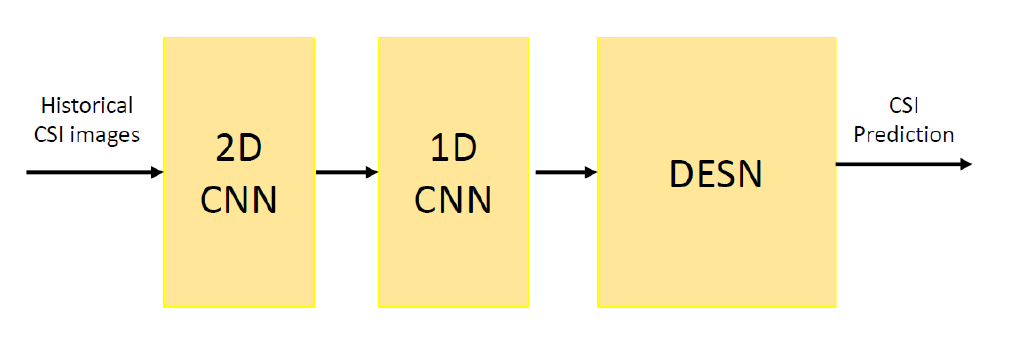
Figure 1. The forecasting